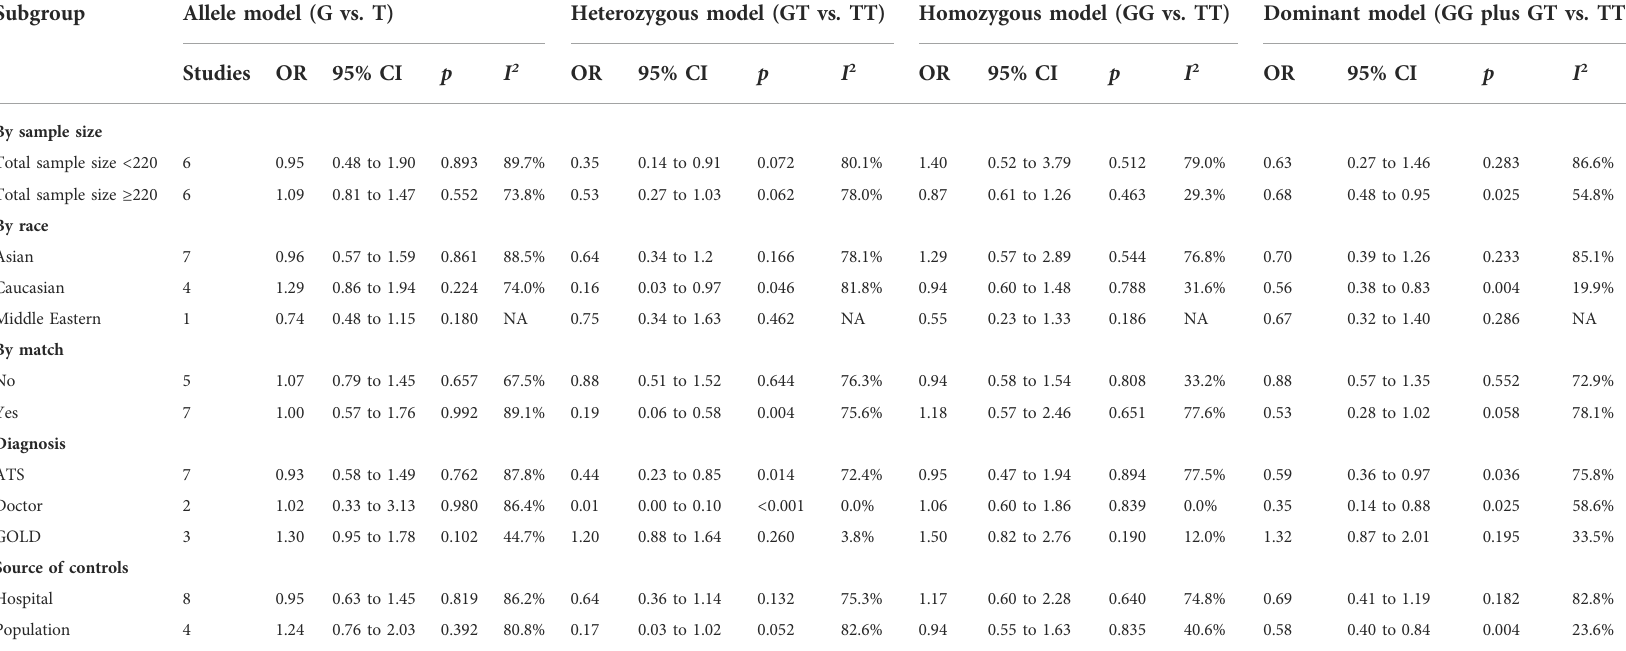
TABLE 2 Subgroup analyses of VDBP gene rs7041 polymorphism with COPD risk under 4 models of inheritance. Subgroup Allele model (G vs .